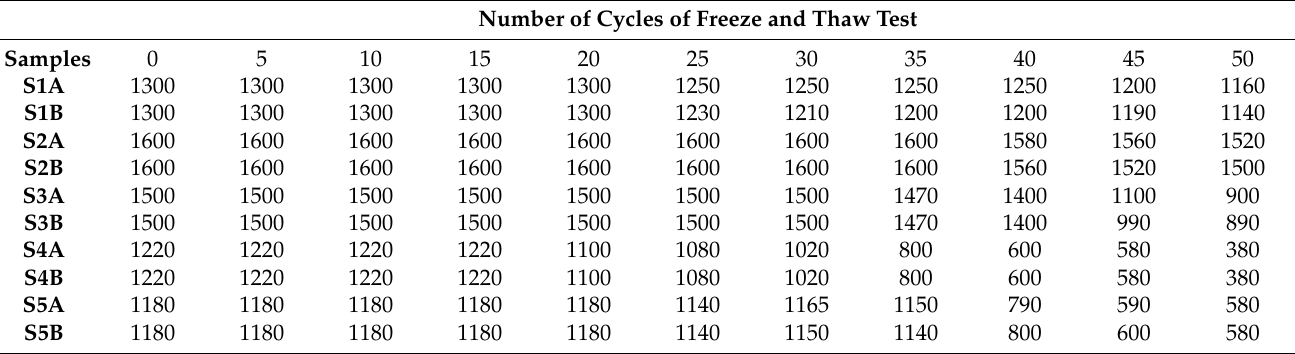
Table 7. Number of cycles of freeze and thaw tests of the tested concrete